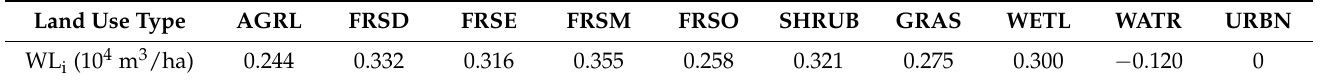
Table 5. Water retention amount per unit area of different land use types.